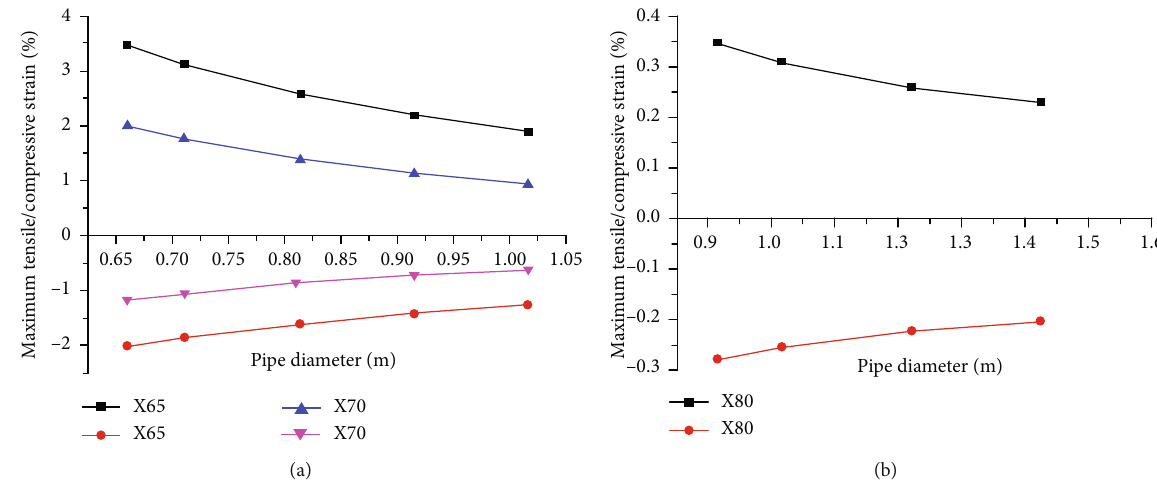
Figure 11: Relationship between maximum tensile and compressive strains and pipe diameter: (a) X65 and X70 steel grade and (b) X80 steel